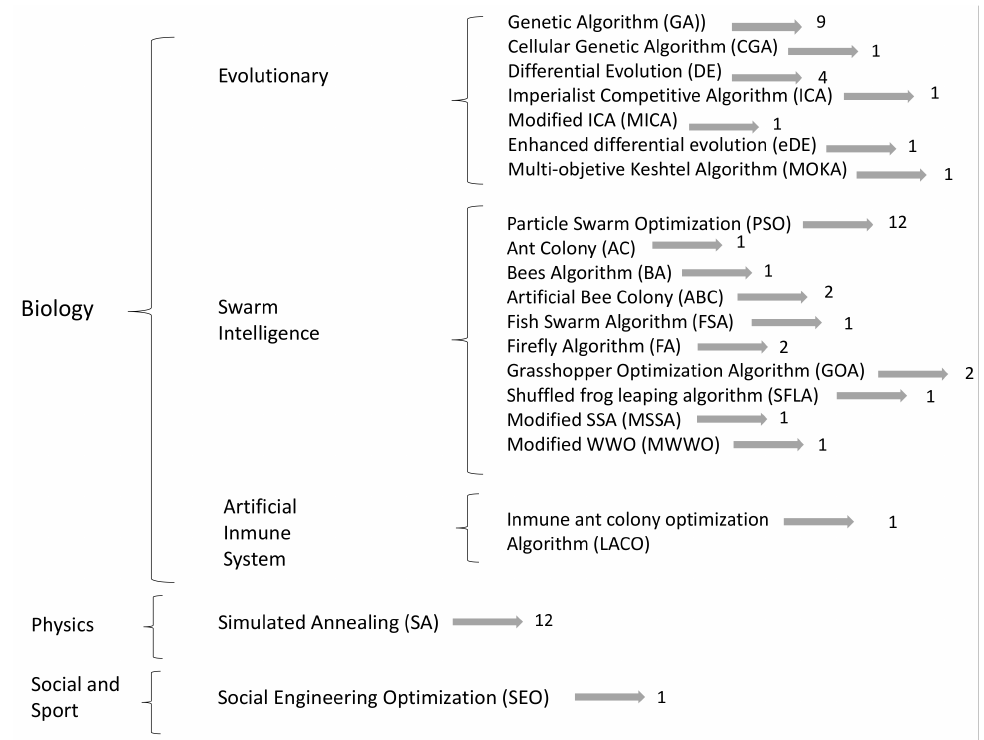
Figure 7. Metaphor-based metaheuristics.